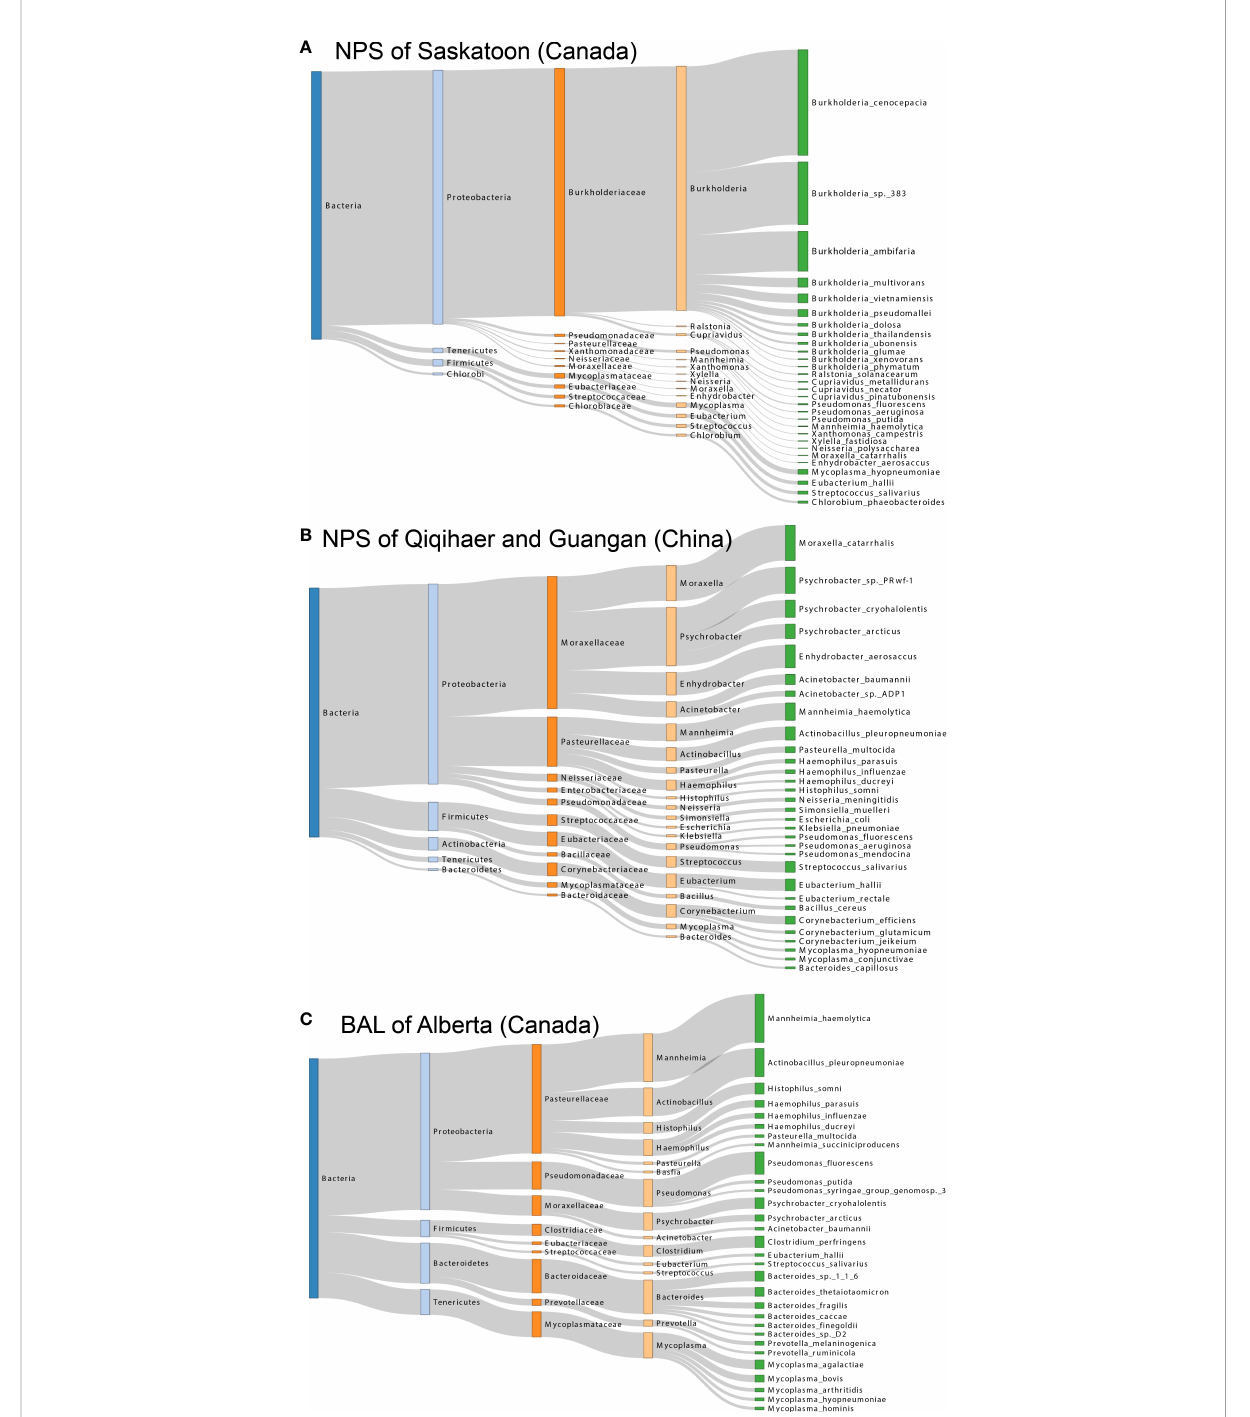
FIGURE 3 Sankey diagram for the major taxonomy structure of bovine respiratory microbiome. (A , B , and C) Sankey diagrams of bovine airway microbiota among NPS of Saskatoon (Canada), NPS of Qiqihaer and Guangan (China), and BAL of Alberta (Canada), which depict the bacterial fl ow of taxonomy from the kingdom to species level. NPS, nasopharyngeal swab; BAL, bronchoalveolar